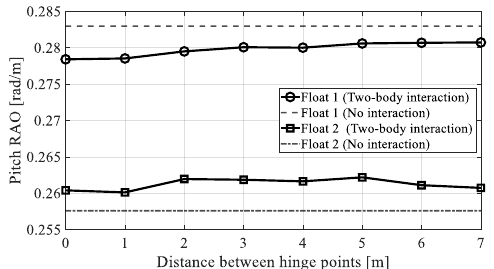
Figure 13. Comparison of the added mass and radiation damping coefficients of the float at Chilbaldo.